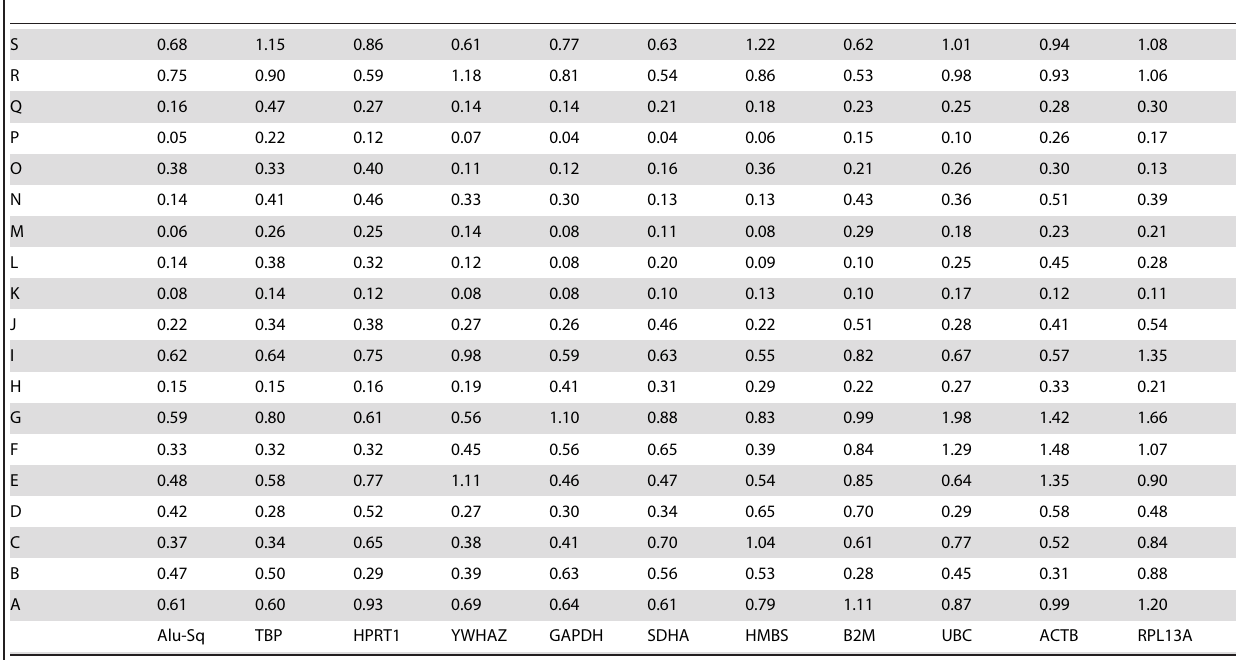
Table 1. M-values for the candidate reference genes under different treatment